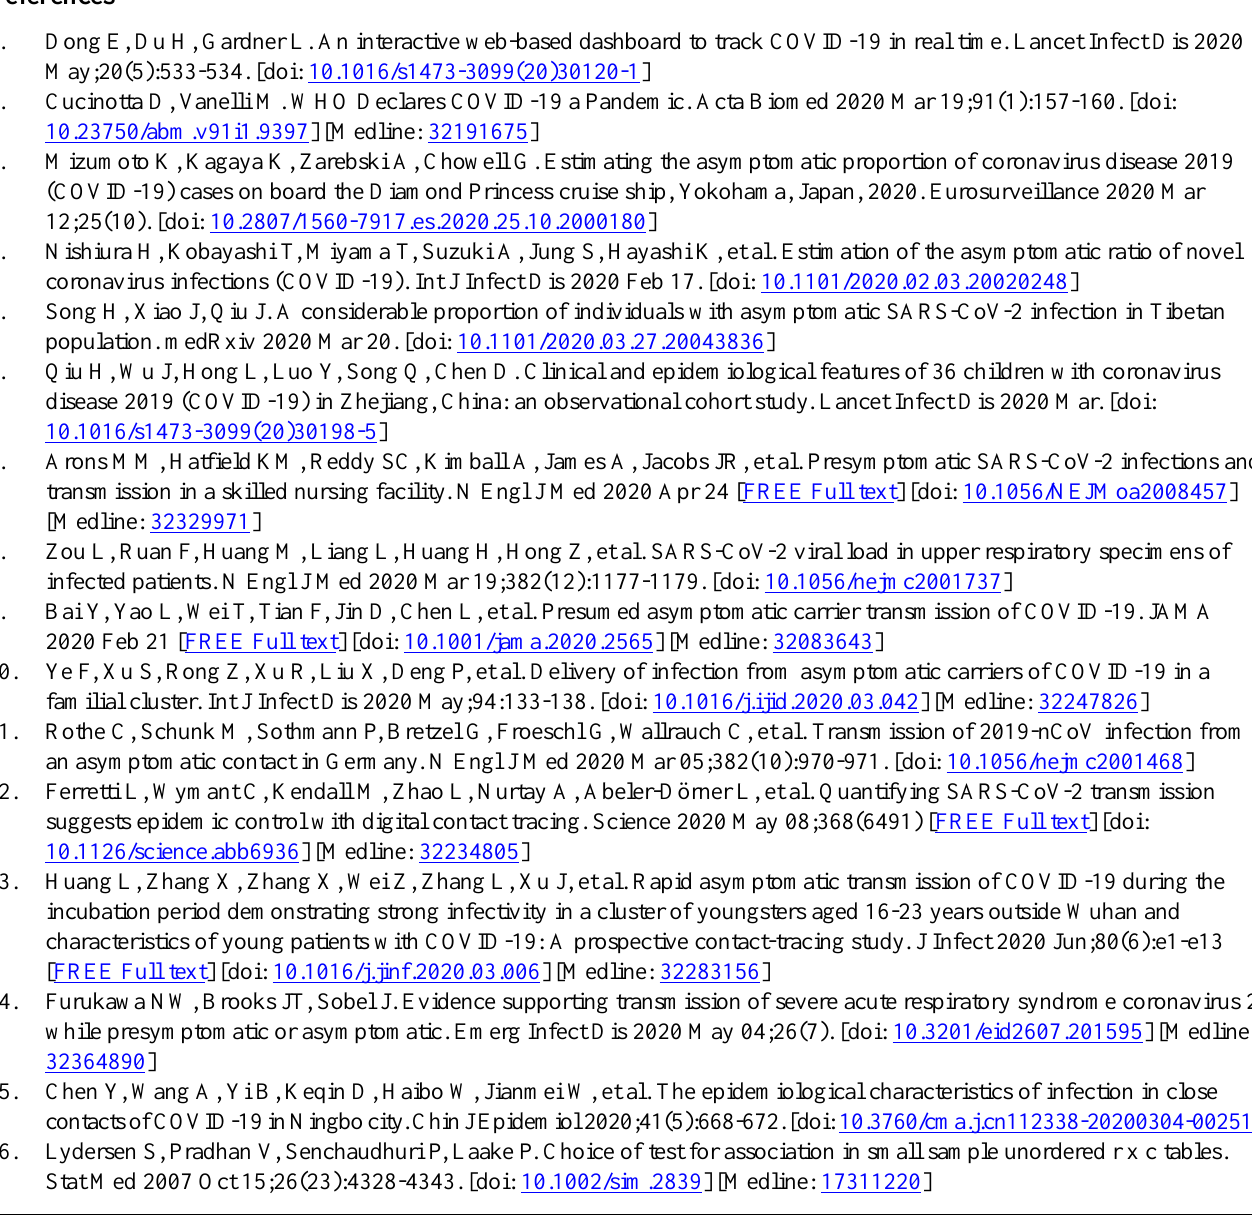
COVID-19: coronavirus